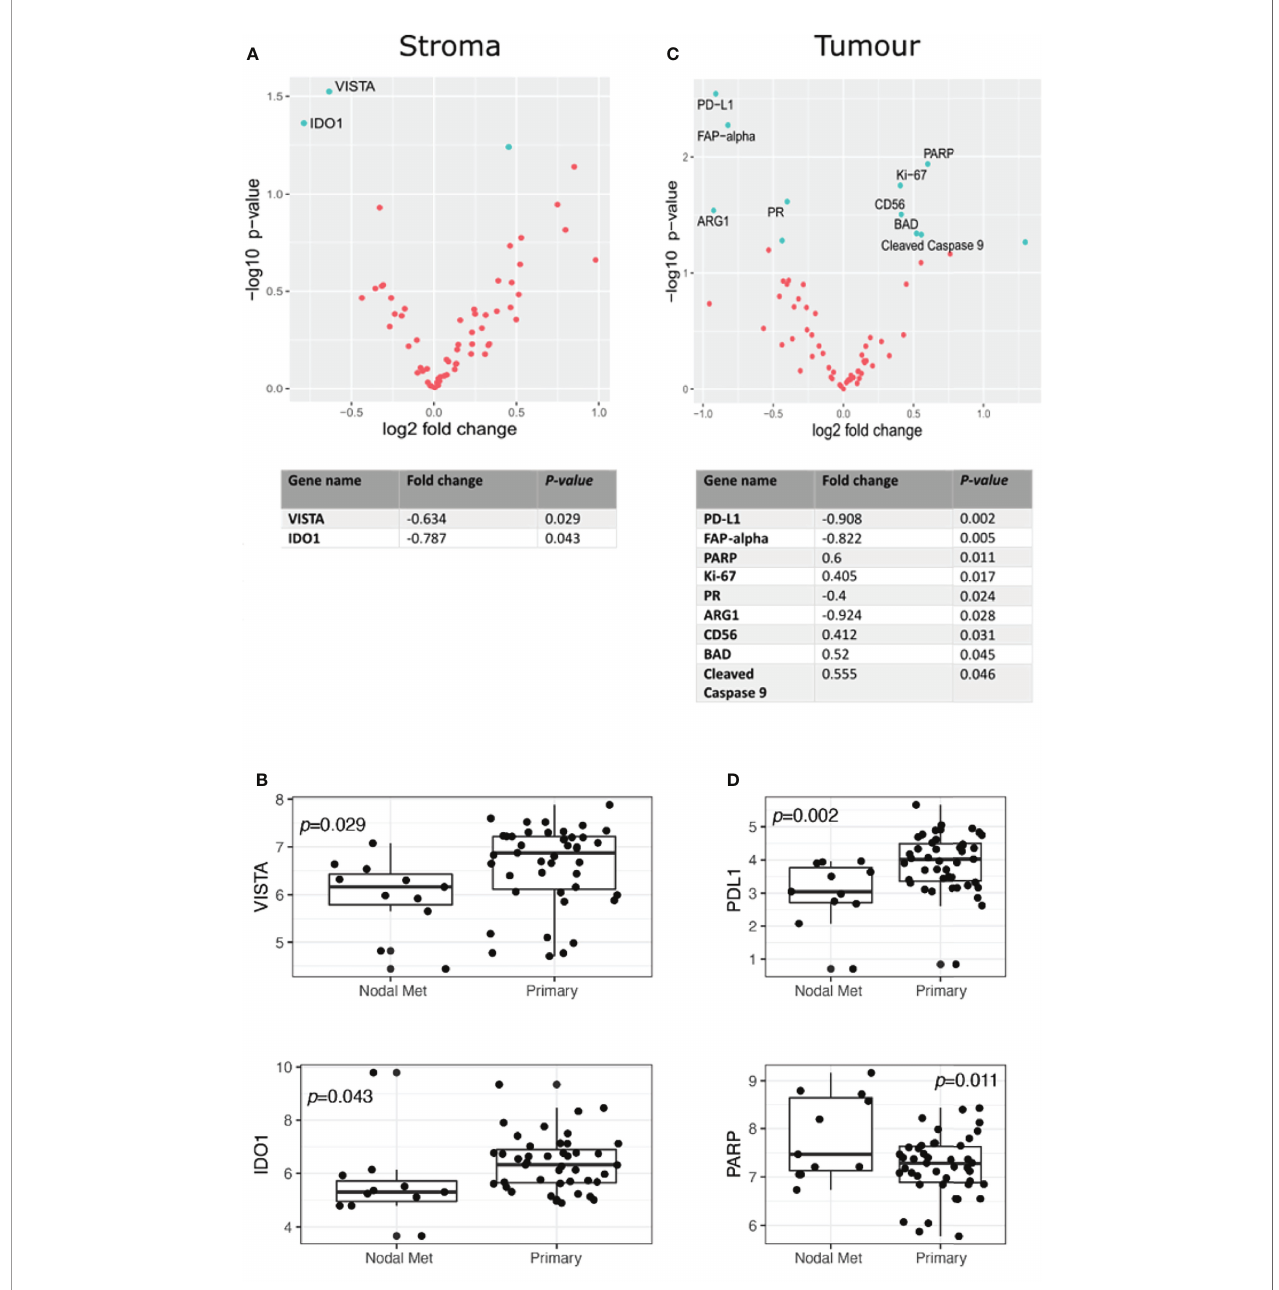
FIGURE 2 | Differential protein expression compared to specimens from unmatched OPSCC primary (n = 43) and nodal metastasis (n = 11). (A) Upper panel. Volcano scatter plot showing stromal enrichment of proteins in primary (left) vs nodal metastases (right) ranked by signi fi cance ( − log10 P -value). Lower panel. List of top two signi fi cant deregulated proteins ranked by P -value. (B) Boxplots indicating VISTA and IDO1 enrichment in primary tumors. (C) Upper panel. Volcano scatter plot showing tumor region enrichment of proteins from primary (left) vs nodal metastases (right) ranked by signi fi cance ( − log10 P -value). Lower panel. List of top nine signi fi cant deregulated proteins ranked by P -value. (D) Boxplots indicating enrichment of PD-L1 and PARP in primary tumors and nodal metastases,